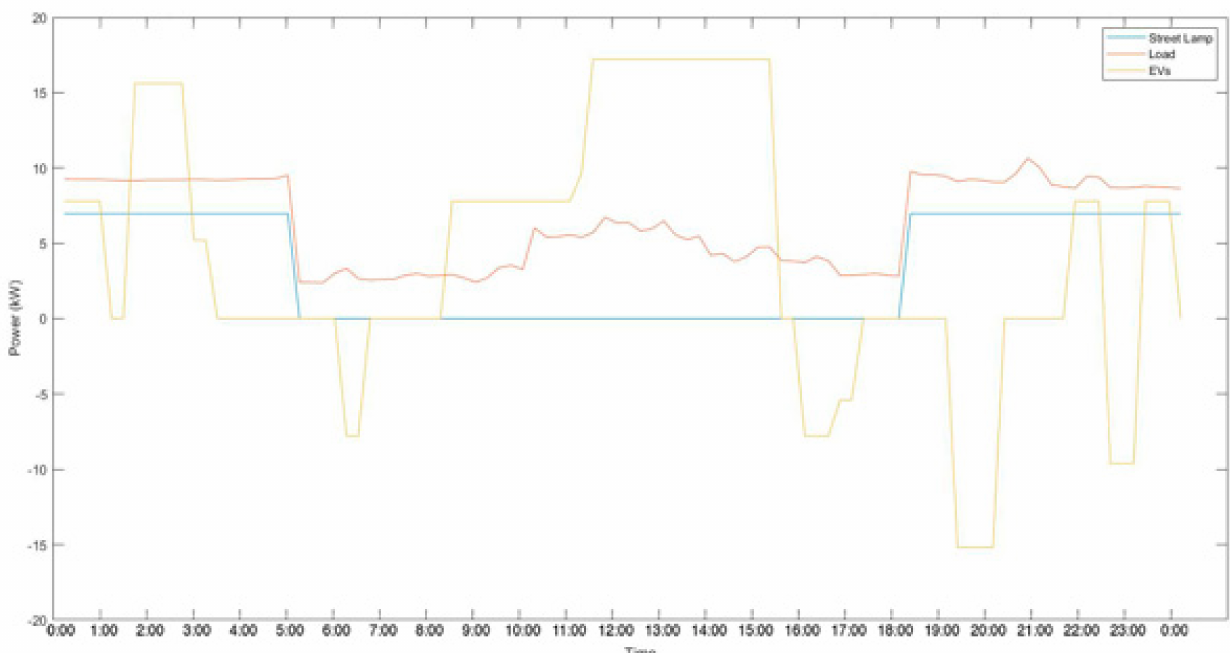
Figure 6. Total electricity consumption by houses, streetlamp and EVs (NG, FG).